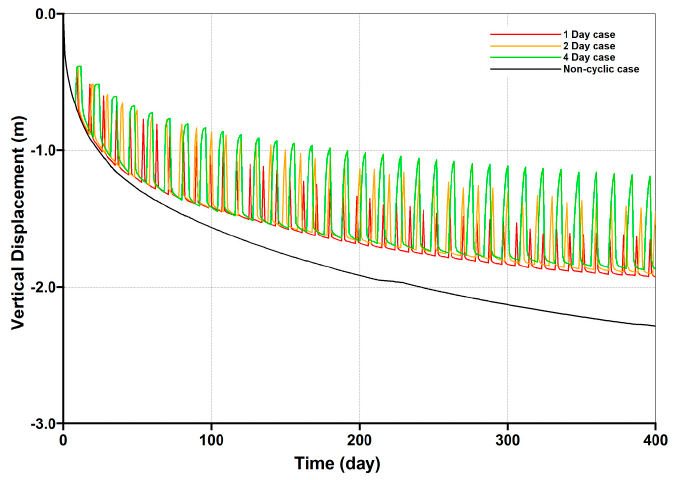
Figure 16. Results of vertical displacement by use of different production time during secondary depressurization stage.